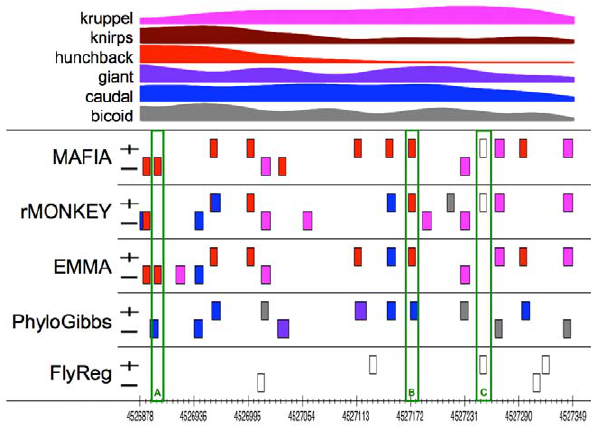
Figure 7. An example D.melanogaster developmental enhancer. At top are F-Seq scores from ChIP-seq data for six transcription factors (kr = kruppel , kni= knirps , hb= hunchback , gt= giant , cad= caudal , bcd= bicoid ); curves were scaled to maximize visual impact for the figure. Predictions and known sites are shown below, with colors denoting factor identity as per the F-Seq curves (factor tailless was not assayed in the ChIP-seq experiments and is shown in white). Plus and minus tracks correspond respectively to sense and antisense strands of the dm3 assembly for chromosome 3R. The FlyReg track depicts known binding sites according to the ‘‘gold standard’’ (see text). The EMMA track was produced using the –e option for that program.